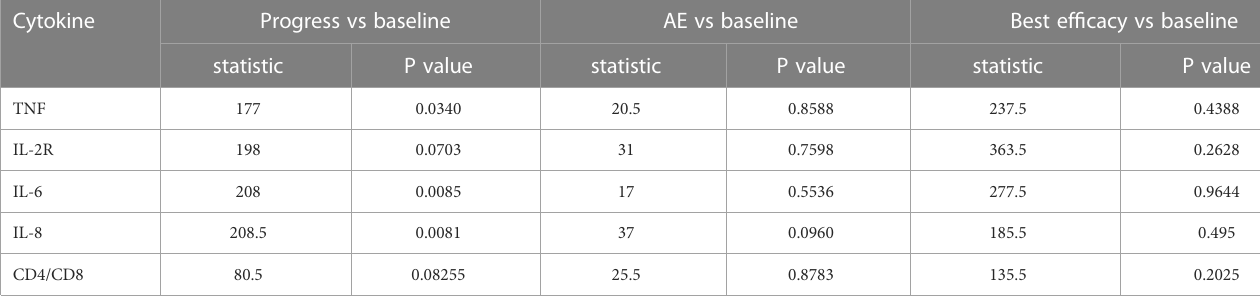
TABLE 3 Results of Wilcoxon test between cytokine levels at baseline and other detection timepoints.